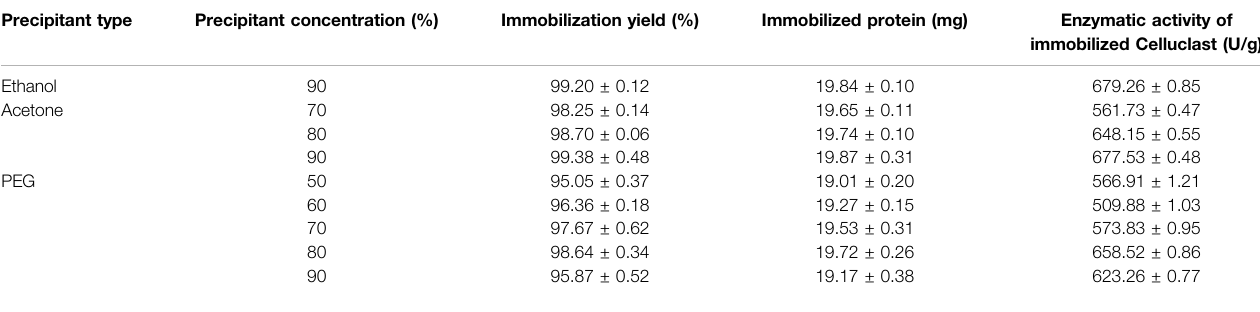
TABLE 2 | Immobilization performance of Celluclast ® -CLEAs at different precipitant conditions. Precipitant